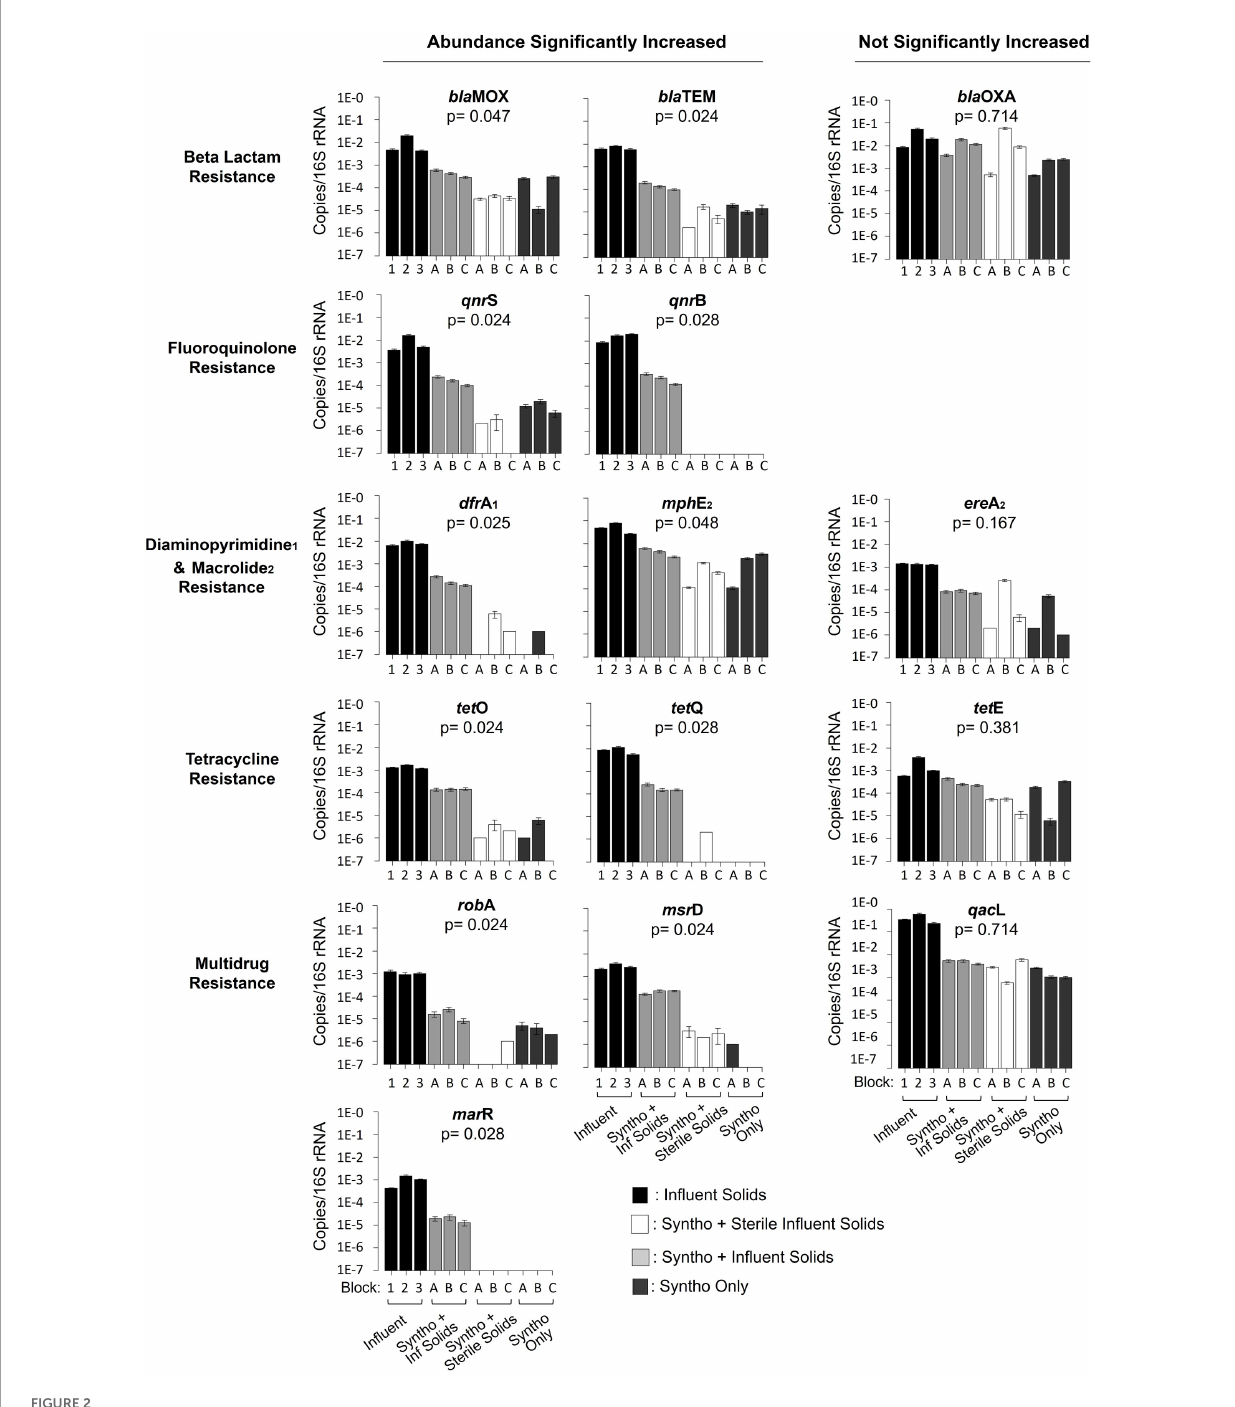
FIGURE2 Quantification of antibiotic resistance genes using droplet digital PCR. Reactors with immigration received Syntho and influent solids. Reactors receiving Syntho and sterile influent solids acted as a substrate control. Reactors receiving Syntho only acted as a no immigration continuity control. The Block represents the inoculum source of the reactors; A- La Prairie ML, B- Cowansville ML, C- Pincourt ML, Influent samples are numbered based upon the order received by the reactors during Phase 2. Each bar represents a composite sample of three biological replicates. The Error bars represent the standard error between duplicates. The Mann-Whitney U Test was used to assess the statistical significance of the change in abundance of each ARG with immigration when compared to the sterile and no immigration control